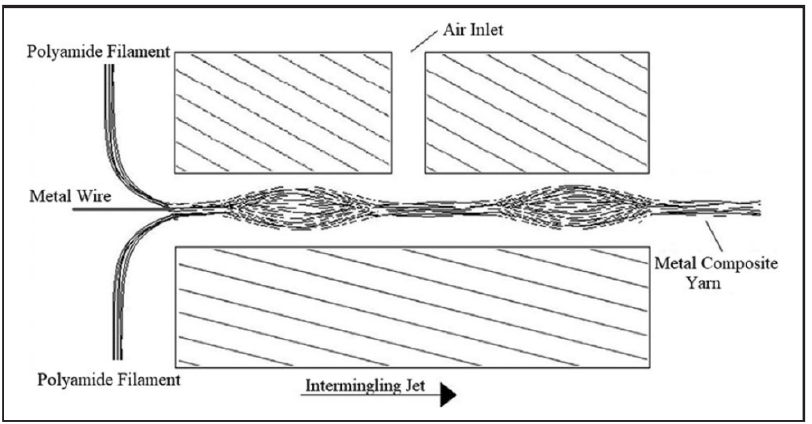
Figure 16. Intermingling process. Reprinted from Reference [66] under Creative Commons license.